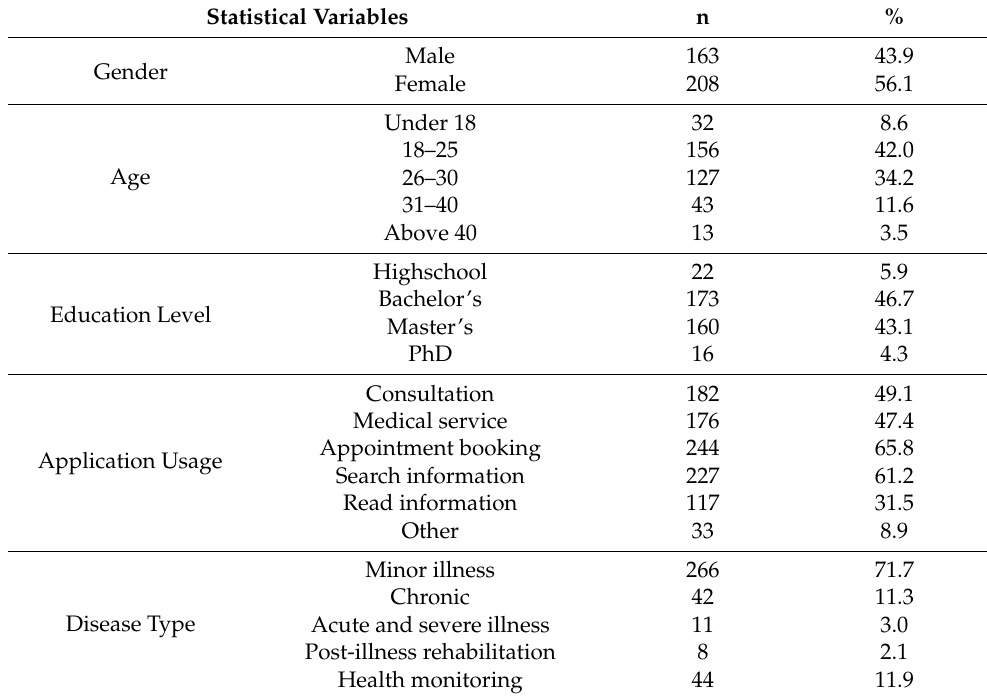
Table 6. Descriptive statistics of demographic variable, application usage, and disease type (n =